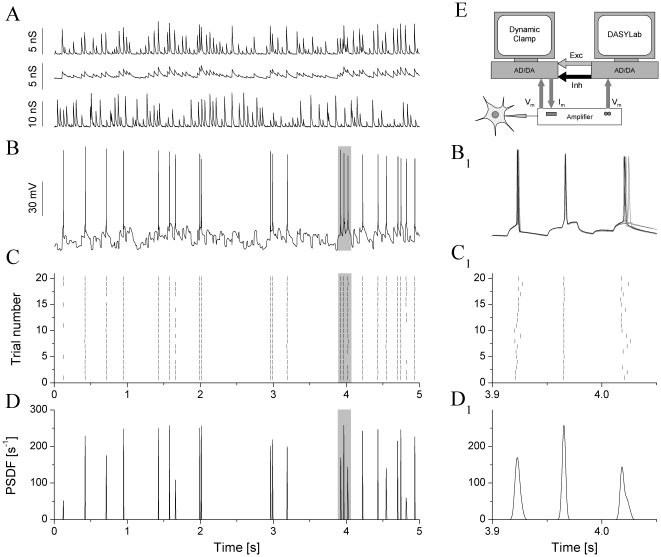
jcBNST neurons display highly reproducible spike responses under the action of simulated synaptic inputs.One excitatory and one inhibitory presynaptic voltage waveforms are used to generate a total of three synaptic conductances: 1 fast (AMPA-type), 1 slow (NMDA-) excitatory and 1 fast inhibitory (GABA-) inputs for the jcBNST neuron (A). The type II neuron on B responds with irregular firing when stimulated with the above inputs, but this pattern is very reproducible across trials, as shown by the peri-stimulus scatter plot in C. Peri-stimulus spike density function (PSDF) of the above pattern is shown in D. The right side panels (B1, C1, D1) are zoomed sections of the corresponding graphs (6 overlapping voltage traces shown in B1). The third spike event is less reliable and less precise than the preceding two. The schematic of the dynamic clamp system is shown in E.